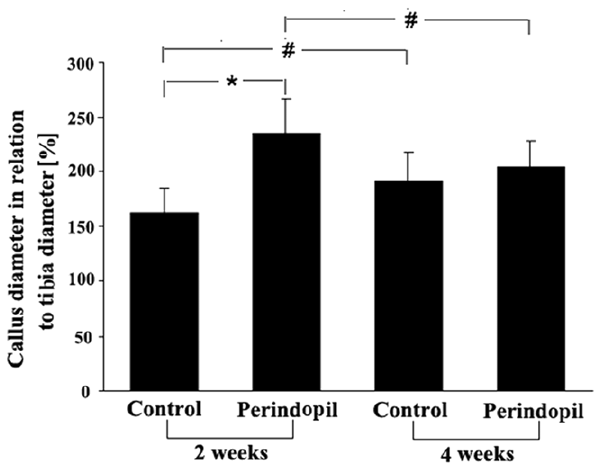
Figure 1. Radiological analysis of callus diameter in relation to the diameter of the tibia at the fracture site after perindopril treatment. All data are given as mean 6 s.d. *P , 0.05 versus corresponding values of the vehicle-treated controls. # P , 0.05 versus corresponding values of specimens at 2 weeks post-fracture (n=6 per group).